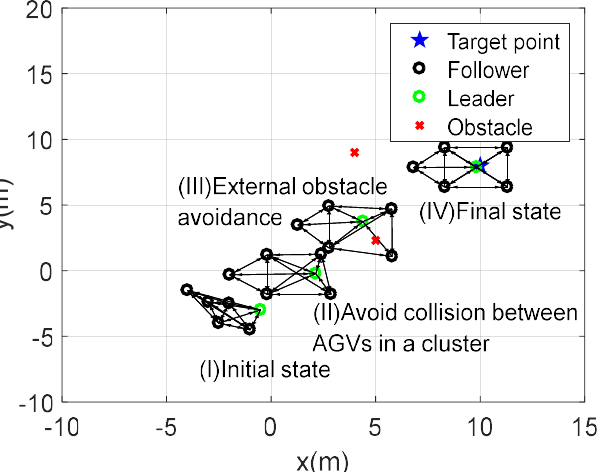
Figure 6. Single cluster motion process after modifying channel environment. The figure shows the formation in four cases. The four cases are: initial state, avoid collision between AGVs in a cluster, External obstacles avoidance, final